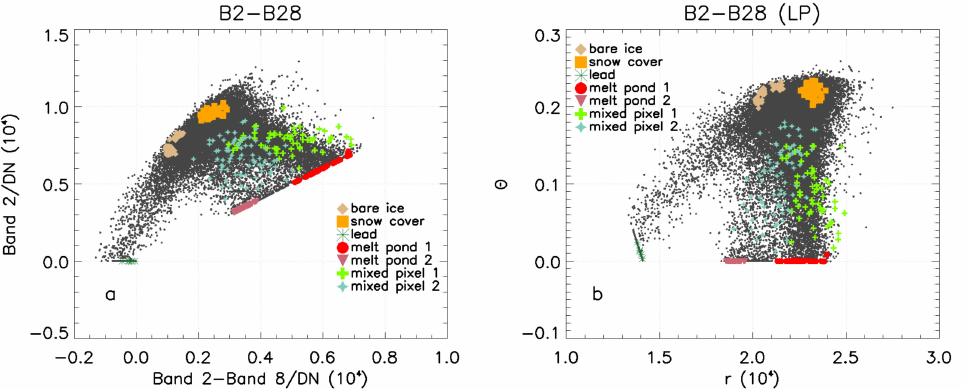
Figure 2. True-color training samples. ( a ) The S2 sample and ( b ) the corresponding L8 sample. For the S2 data of Figure 2a, B2 (457–522 nm) and B8 (784–900 nm) are used in the LinearPolar algorithm [15] to obtain a scatterplot of B2 and the difference between B2 and B8 (B28), in which the ice/snow pixels and melt pond pixels are distributed along two lines, and two types of mixed pixels are located between these two lines (Figure 3a). The intersection of these two lines is taken as the origin of polar coordinates, and the values of B28 and B2 are transformed to polar coordinate values (Figure 3b). The bare ice and snow are located on one line (sea ice axis), which was set to 0 MPF (the threshold of the sea ice axis is denoted by θ t ), and two types of melt ponds are located on another line (melt pond axis), which was set to 100% MPF (the threshold of the melt pond axis is denoted by θ t 0 ). Both lines are parallel to the horizontal axis; therefore, the thresholds of the sea ice axis and melt pond axis can be determined.